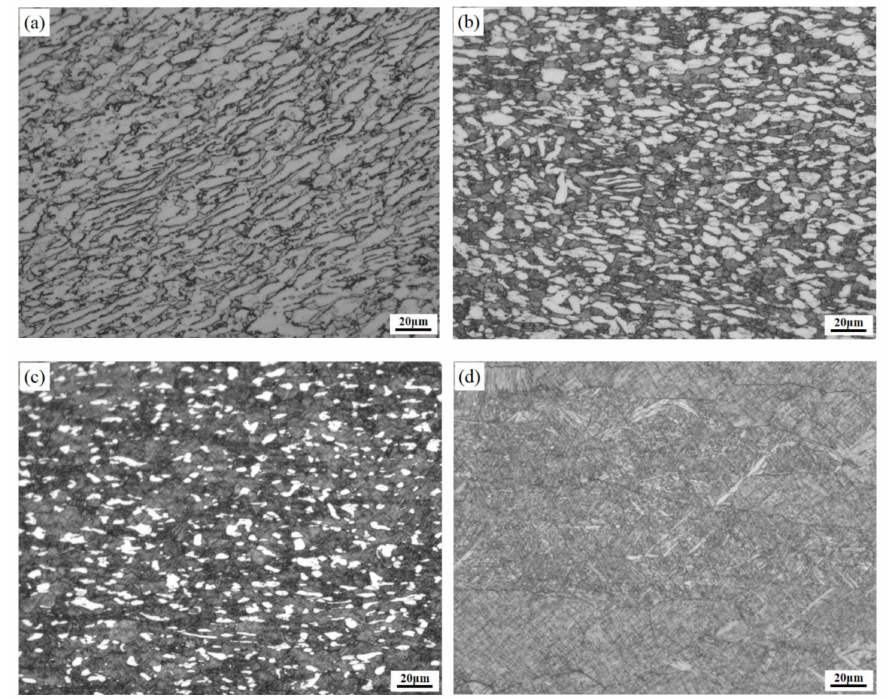
Figure 4. The light microscope (LM) microstructure of Ti-6.5Al-3.5Mo-1.5Zr-0.3Si alloy after defor- mation at: ( a ) 1123 K/0.1 s − 1 , ( b ) 1223 K/0.1 s − 1 , ( c ) 1223 K/10 s − 1 , and ( d ) 1323 K/0.1 s − 1